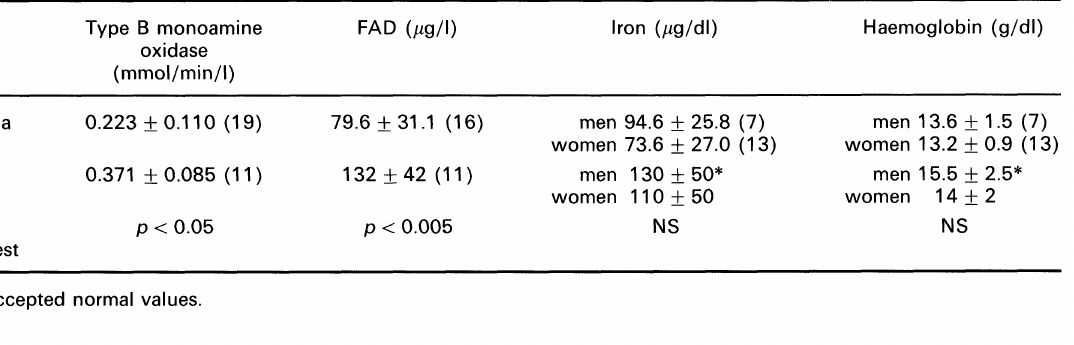
Table2. Diamine oxidase activity and cofactor level in atopic eczema patients and healthy